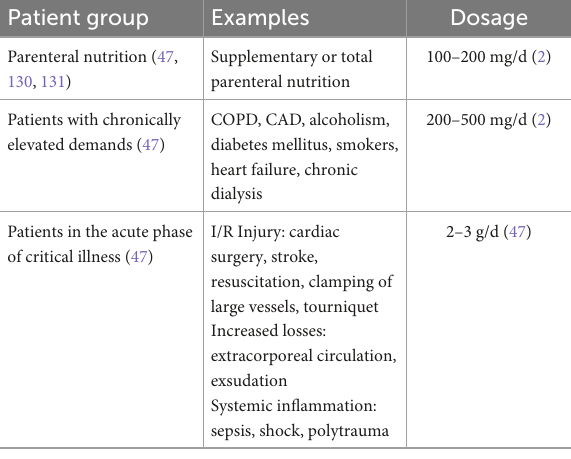
TABLE 4 Recommendations for vitamin C dosing according to the ESPEN Micronutrient Guideline (47) and nutrition in the ICU